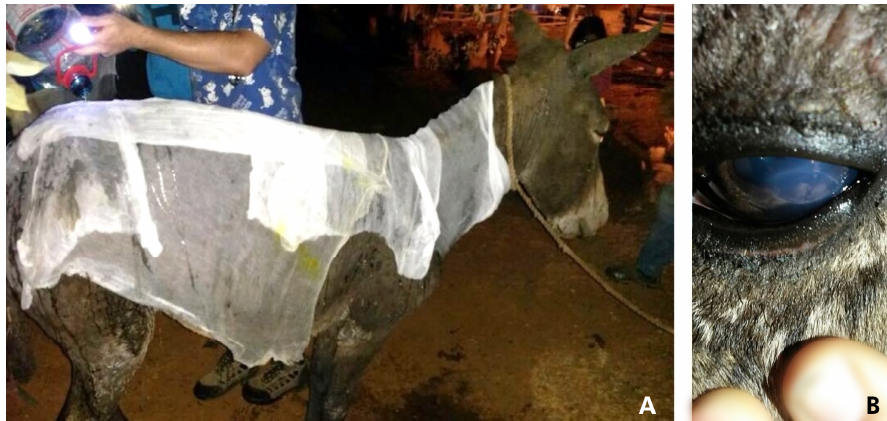
Figure 1. Donkey 1 received emergency medical attention for thermal injuries. ( A ) A large gauze dressing was applied over his body and soaked with tap water. ( B ): corneal ulcer.